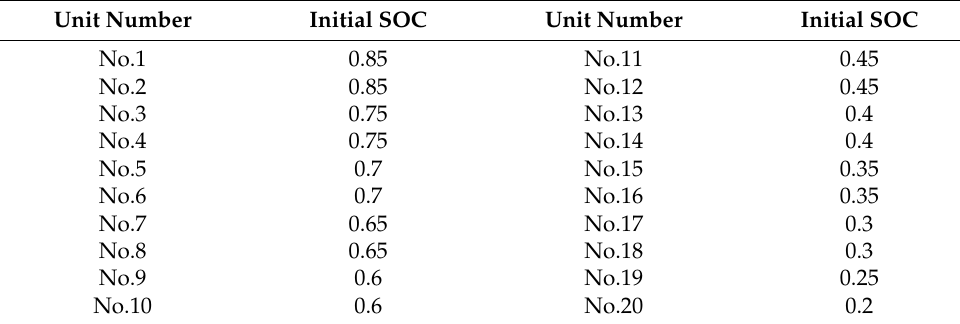
Table 2. Initial SOC of battery energy storage unit.